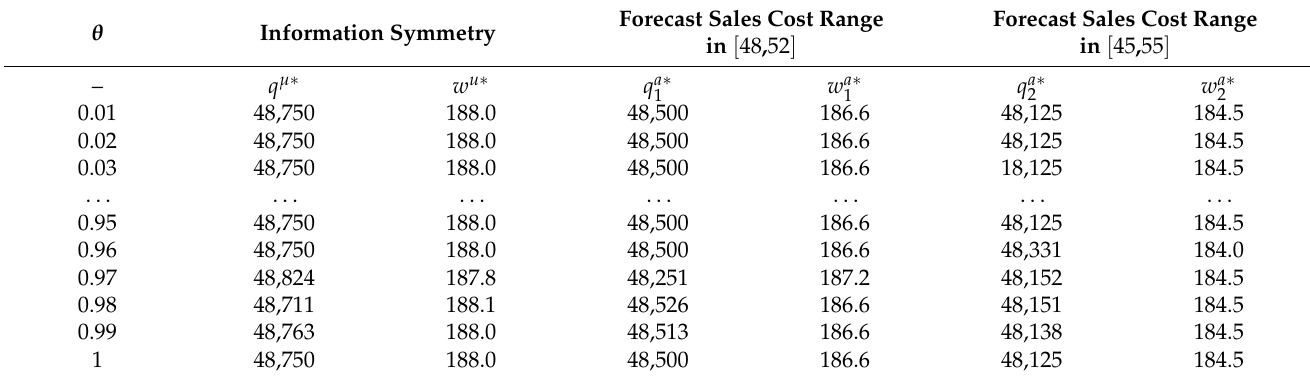
Table 2. Optimal order quantity and wholesale price change between [ 0.01,1 ] in steps of 0.01.